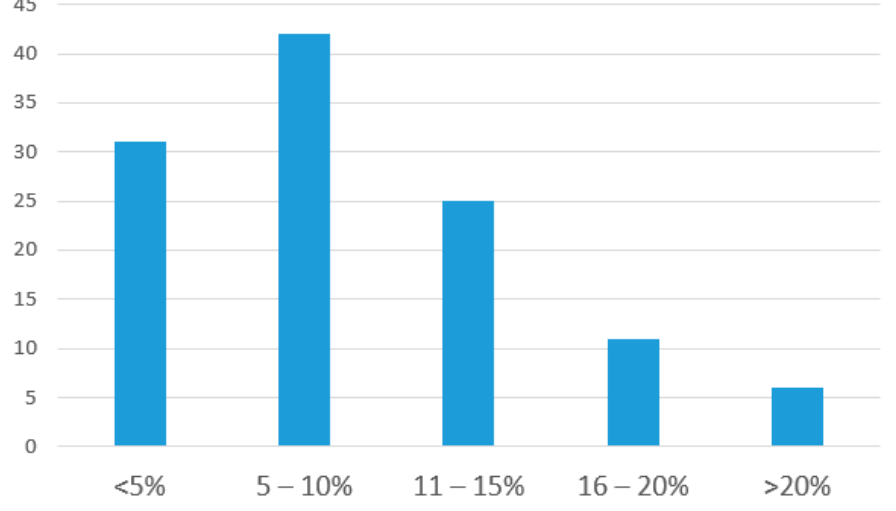
Figure 4. Absolute frequency of mark-up percentage distribution. Table 2. Influence of estimated value of procurement on bid price assessment.